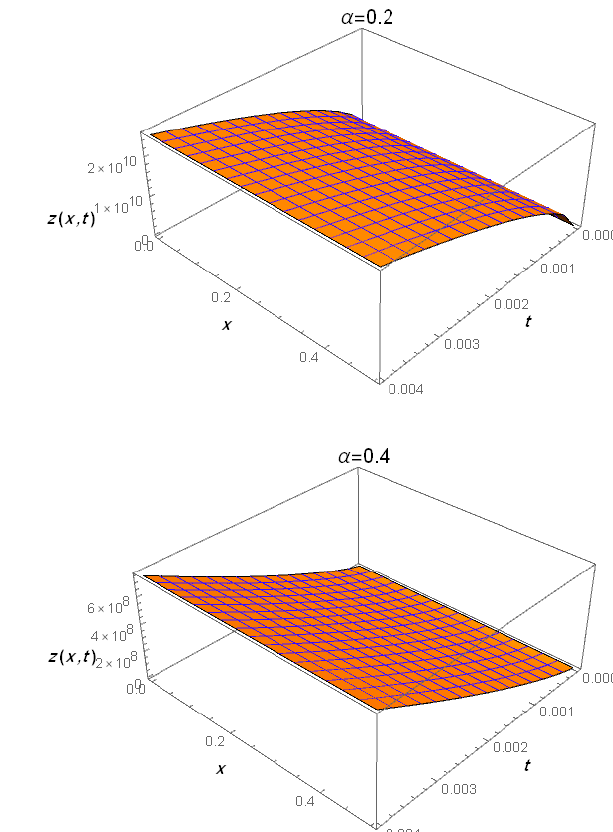
Figure 1. 2D graphs of neutron flux 𝑧(𝑥, 𝑡) for α = 0.1, 0.2, 0.3, 0.5. and 𝑧 (cid:2868) (𝑥) = 1.